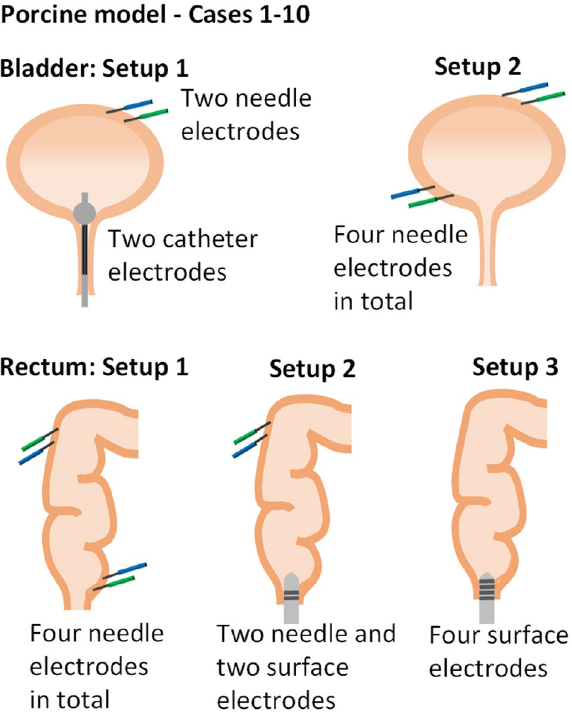
Figure 3. Schematic of the electrode positioning setups for impedance measurement on the urinary bladder and rectum. In cases one to ten four electrodes per organ were needed, in cases eleven and twelve two electrodes per organ were used. Urinary bladder: Setup 1 uses needle electrodes and catheter electrodes; Setup 2 uses needle electrodes only. Rectum: Setup 1 uses needle electrodes only, Setup 2 uses needle electrodes and surface electrodes on a rectal probe, Setup 3 uses surface electrodes